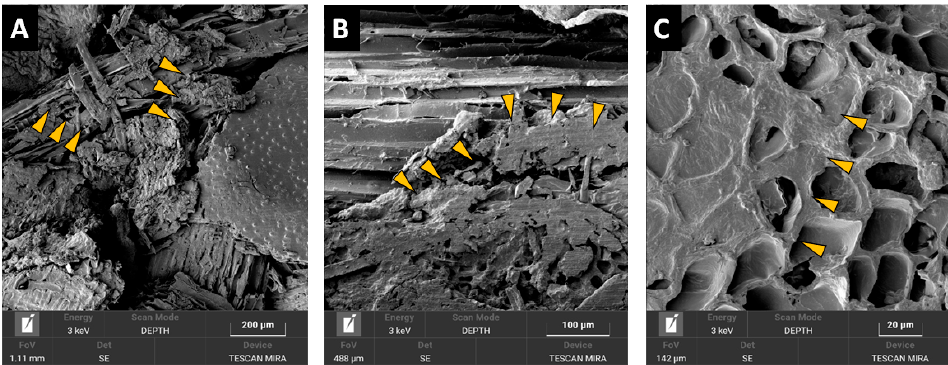
Figure 11. SEM images of the sample from PB board with 50% BSG bonded with 4% pMDI (arrows indicating different failures and adhesive presence in pores).